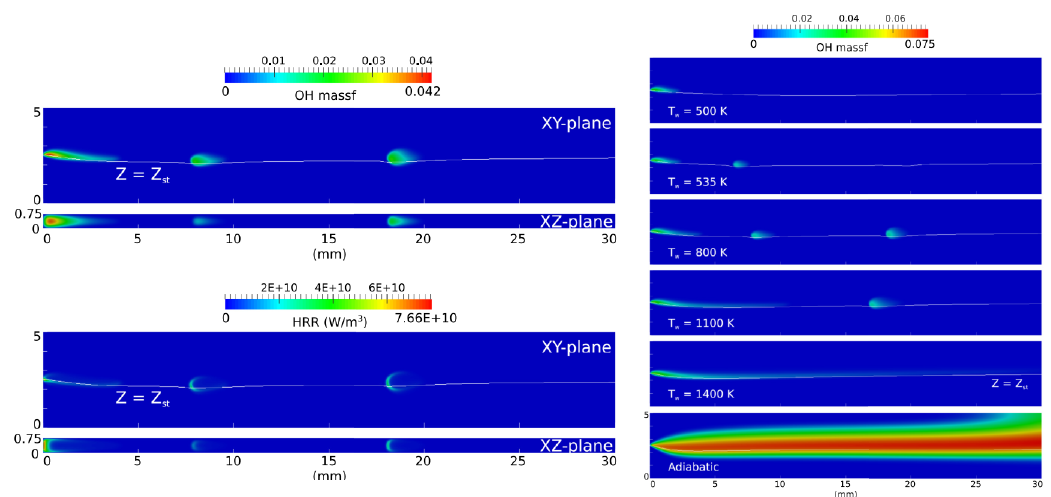
Figure 17. Numerical investigation on the thermo-chemical structures of methane-oxygen diffusion flame-streets in a microchannel by Kang et al. [29]. ( Left ): Contours of OH mass fractions and heat release rate (HRR) on the sliced XY- and XZ-plane along the channel centerline; ( Right ): Effects of wall thermal conditions on flame